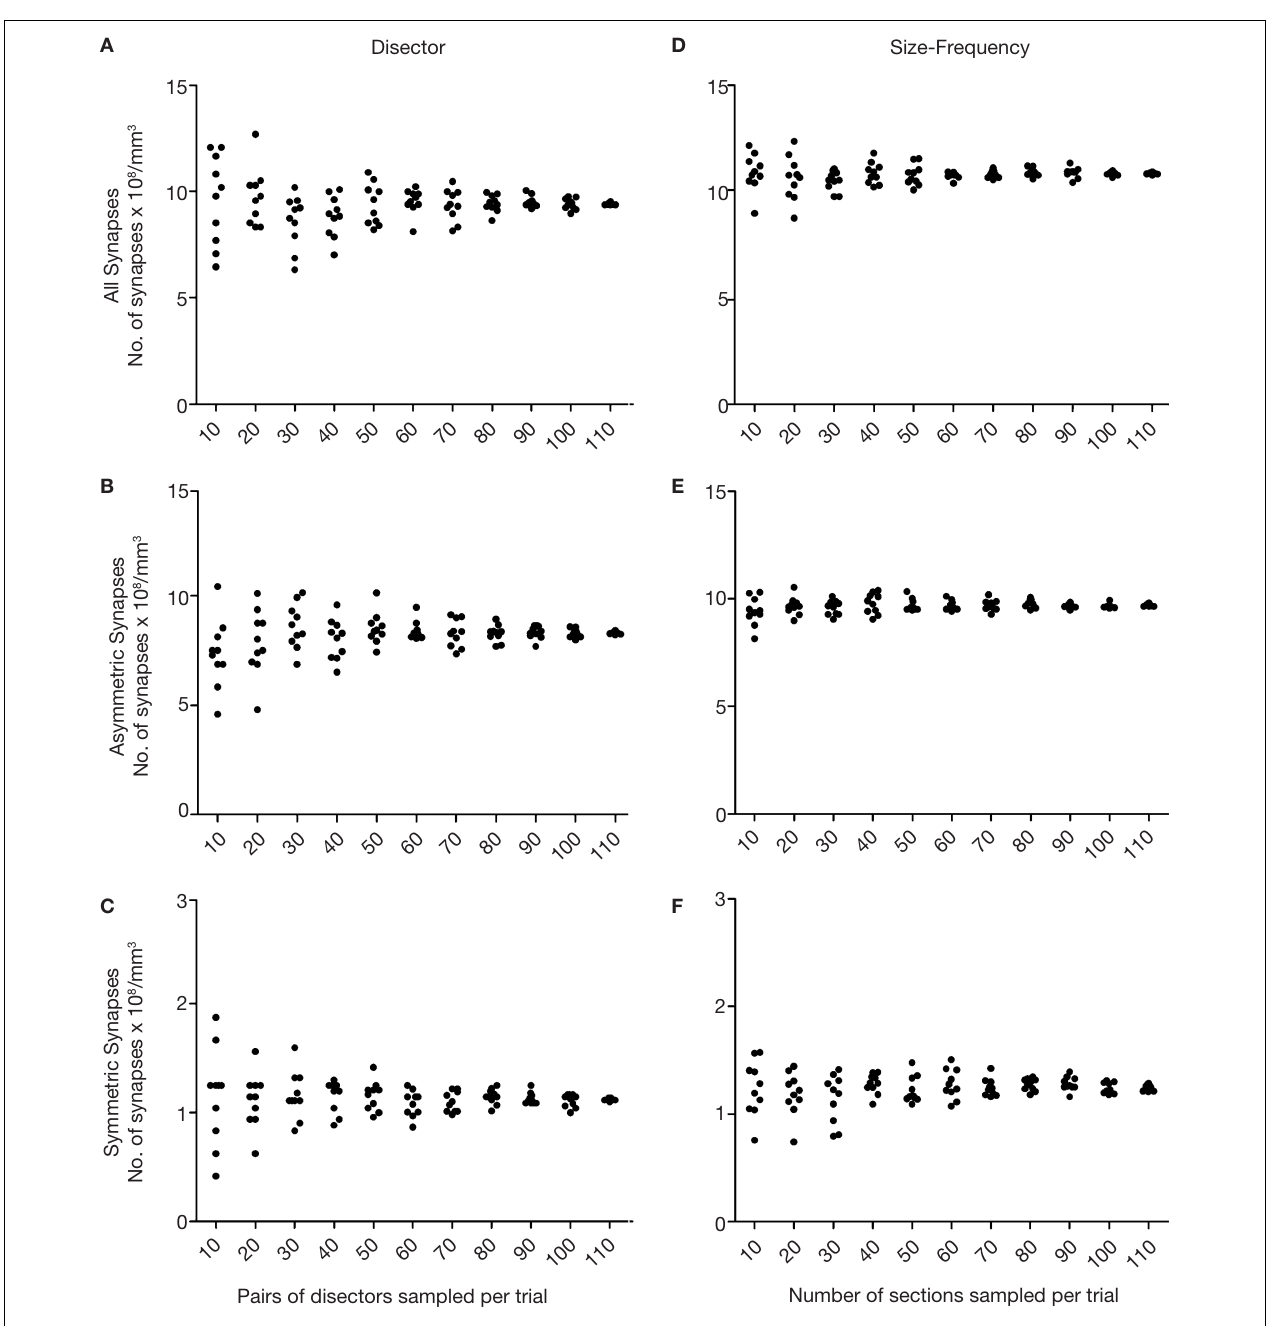
FIGURE 11 | Simulations of the disector and size-frequency methods using different numbers of sections. The data were derived from the same stack of 114 sections used in Figure 10 . In (A) , (B) and (C) , disectors whose h value was three times the section thickness were used (see text and Figure 9 ). The simulation for each type of synapse was carried out as follows. First, 10 pairs of sections were chosen randomly and all the disectors were employed, calculating and plotting the mean value (black dots). This procedure was repeated 10 times. Subsequently, we ran another 10 trials randomly selecting 20 pairs of sections on each trial, and then